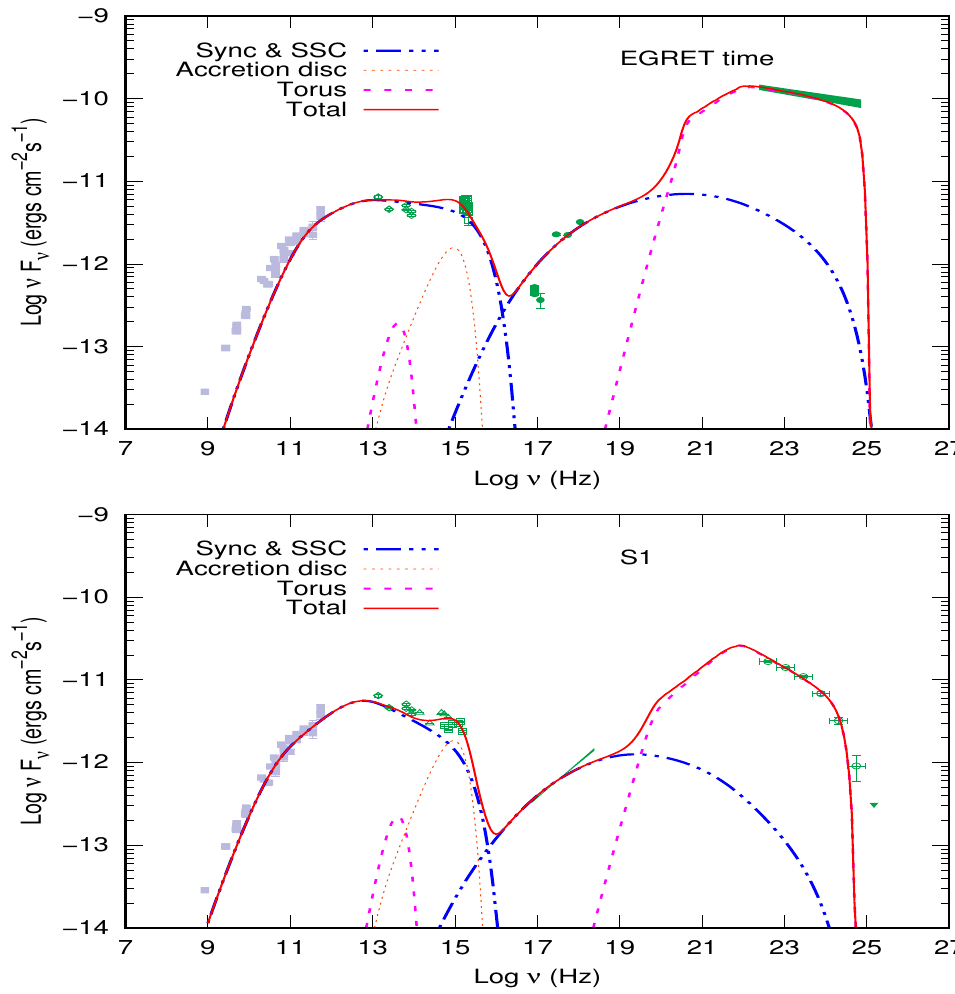
Figure 2. Broad-band SED of PKS 0208-512 during EGRET time and State 1. In the first figure, the filled butterfly diagram: EGRET time, filled circle: X-ray data during EGRET time (see Table 1 for references) and open square: IUE data. For the rest of figures, the data descriptions are as follows: Open circle: Fermi -LAT, filled butterfly diagram: Swift -XRT, open square: Swift -UVOT, filled circle: AstroSat UVIT, unfilled upper-triangle: SMARTS , open diamond: WISE , filled square: archival radio data taken from ASDC SED Builder [93] and downward triangle: upper limit value. The different lines represent the contribution of individual emission component. The solid line represents the total (Sync+SSC+accretion disk + BLR and dusty torus) SED model